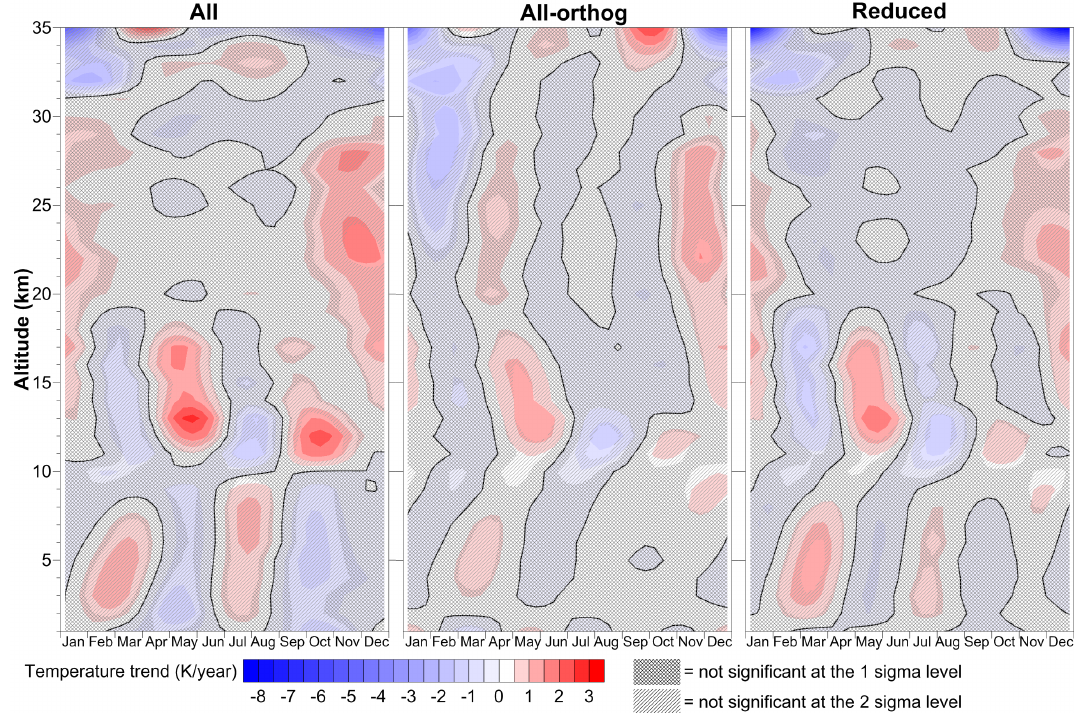
Figure 7. 00:00UT Lindenberg temperature trends as a function of altitude and season for the three different constructs of the regression model. The trends, in Kelvin/year, are shown using the colour scale at the bottom left. Trends that are not statistically significantly different from zero at the 1 σ level are covered in cross-hatching while trends that are not statistically significantly different from zero at the 2 σ level are covered in single-hatching. Trends with no hatching are statistically significantly different from zero at more than the 2 σ